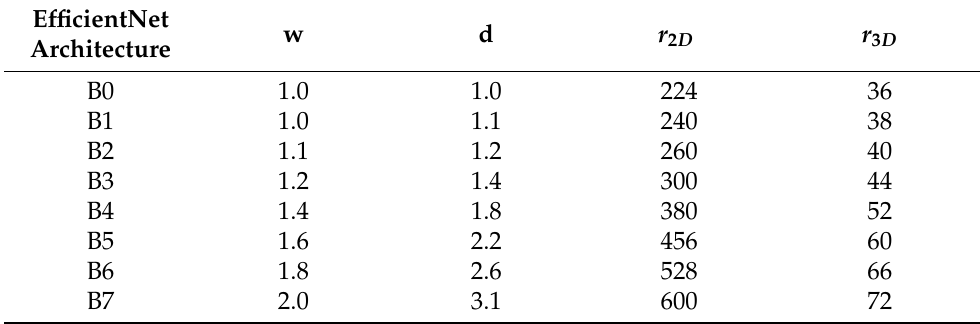
Table 2. Parameters of each of the EfficientNet architectures (width factor, depth factor, 2D resolution, and 3D